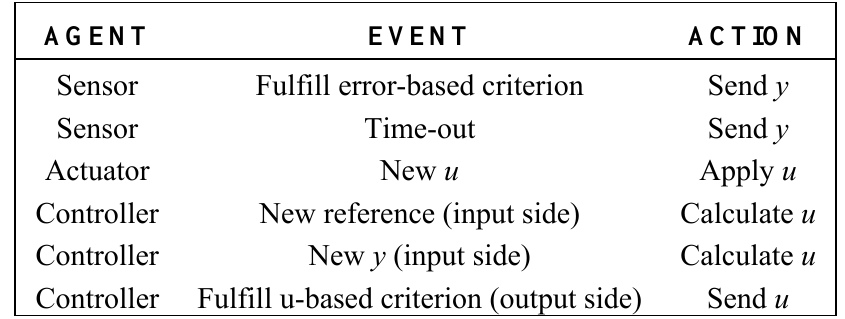
Table 1. Control agents, events, and